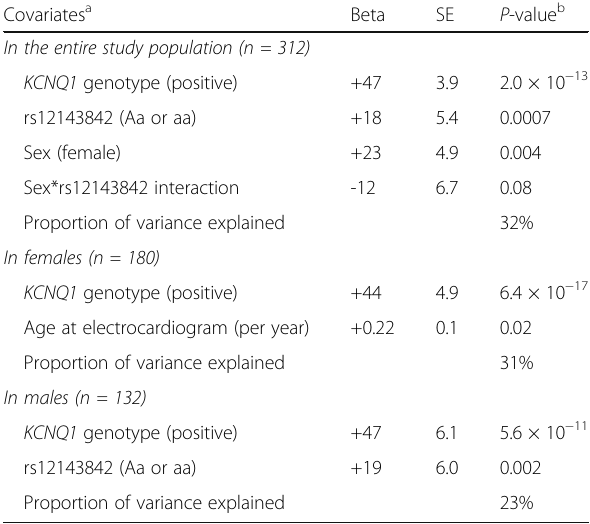
Table 4 Final restricted maximum likelihood model, using pedigree-based measured genotype association, explaining variance in QTc in the LQT1 founder